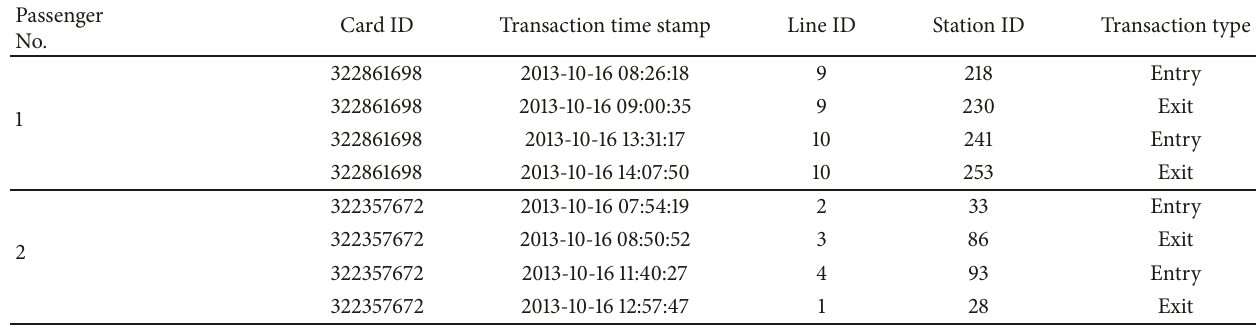
Table 2: Sample data from AFCS.